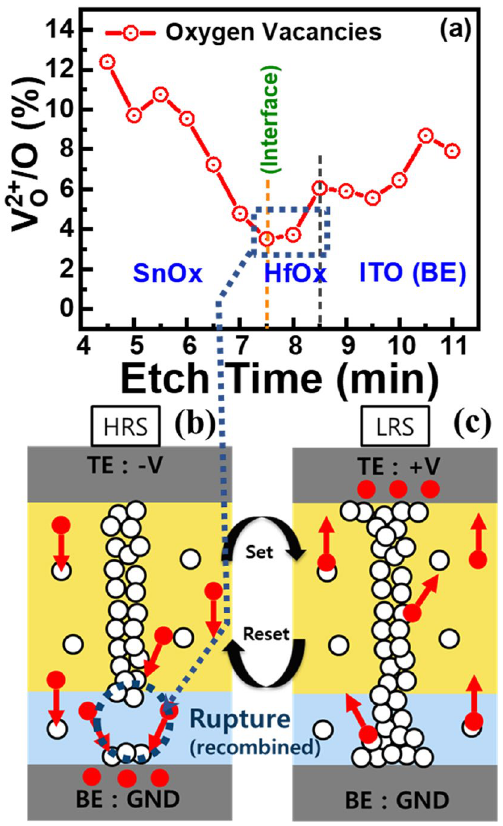
Figure 8. ( a ) Typical oxygen vacancies concentration ratio at different etching depths of ISHI-1 device obtained from XPS depth profile. Schematic resistive switching model during ( b ) reset and ( c )